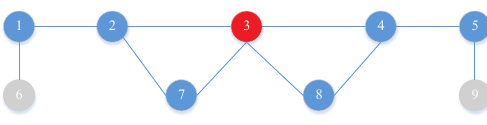
Figure 2. An example of Theorem